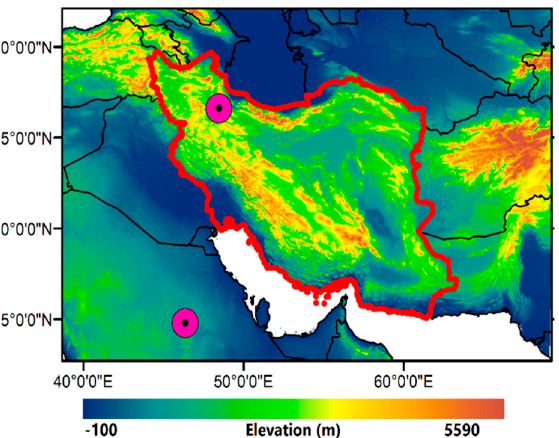
Figure 1. Geographic location of Iran and the two AERONET stations (purple circles) used in this study.